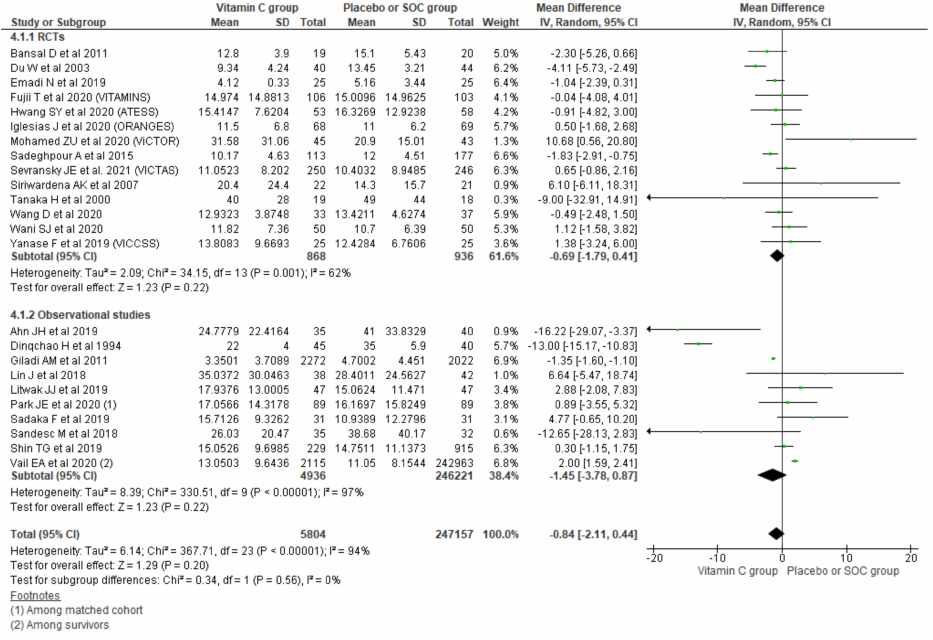
Figure 5. Forest plot showing mean difference of LoHS using random-effect